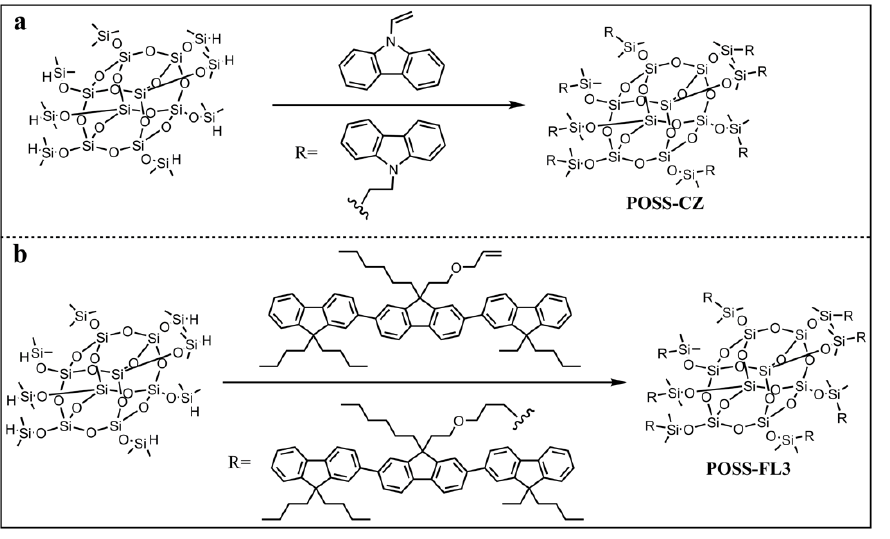
Figure 1. ( a ) Molecular structures of POSS-CZ [68]. ( b ) Molecular structures of POSS-FL3